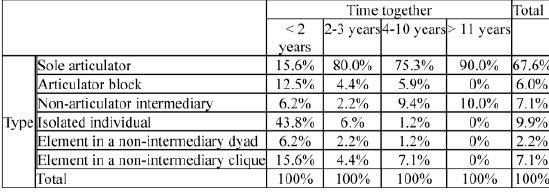
Table 2. Partners as intermediaries by length of time the couple has been together